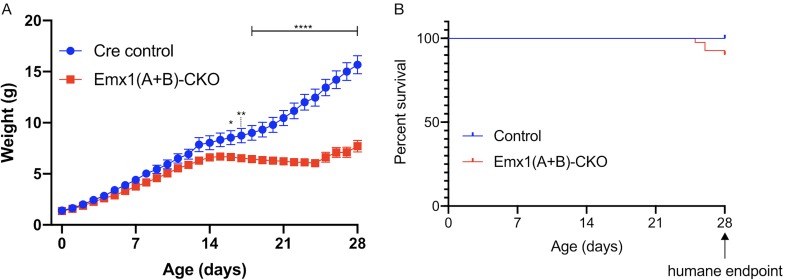
Emx1(A+B)-CKO growth and survival curves.(A) Growth curves of Cre control and Emx1(A+B)-CKO mice. Emx1(A+B)-CKO mice exhibit reduced postnatal growth (two-way repeated measures ANOVA main effect of genotype F1, 19 = 27.14, p<0.0001, main effect of age F28, 532 = 240.3 p<0.0001, interaction F28, 532 = 46.89, p<0.0001; asterisks denote the following p-values from Sidak’s multiple comparisons tests: *=p < 0.05, **=p < 0.01, **=p < 0.001, ****=p < 0.0001; Cre control n = 9, Emx1(A+B)-CKO n = 12). (B) Survival curves of Cre control and Emx1(A+B)-CKO mice. Emx1(A+B)-CKO mice exhibit lethality starting the 3rd postnatal week, and the humane endpoint for survival and behavioral analysis is P28 (Gehan-Breslow-Wilcoxon method χ2 = 5.256, p=0.0219; Cre control n = 41, Emx1(A+B)-CKO n = 41). Source data for Figure 1—figure supplement 5 can be found in Figure 1—figure supplement 5—source data 1. Each tab of the spreadsheet is titled with a letter matching the corresponding figure panel.Figure 1—figure supplement 5—source data 1.Growth and survival data on Emx1(A+B)-CKO mice.